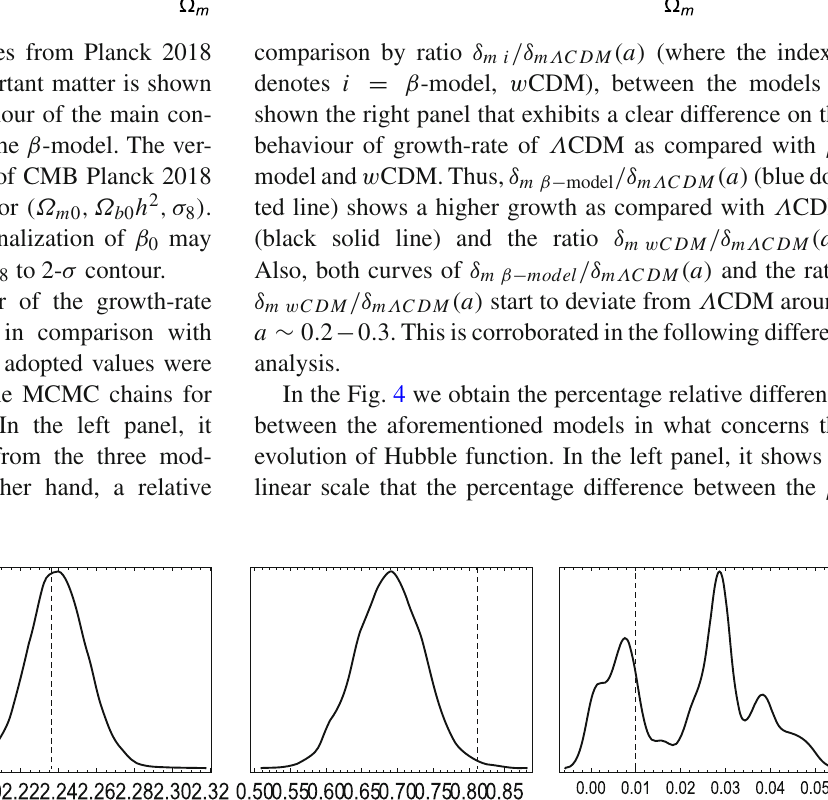
Fig. 1 Contour regions at 1- σ , 2- σ and 3- σ at 68 . 3%, 95 . 4% and 99 . 7% C.L, respectively, of the (σ 8 − Ω m ) and (Ω ) planes. The 2 − Ω b 0 h m black points represent the mean values of the parameters in the MCMC chains of the β -model.